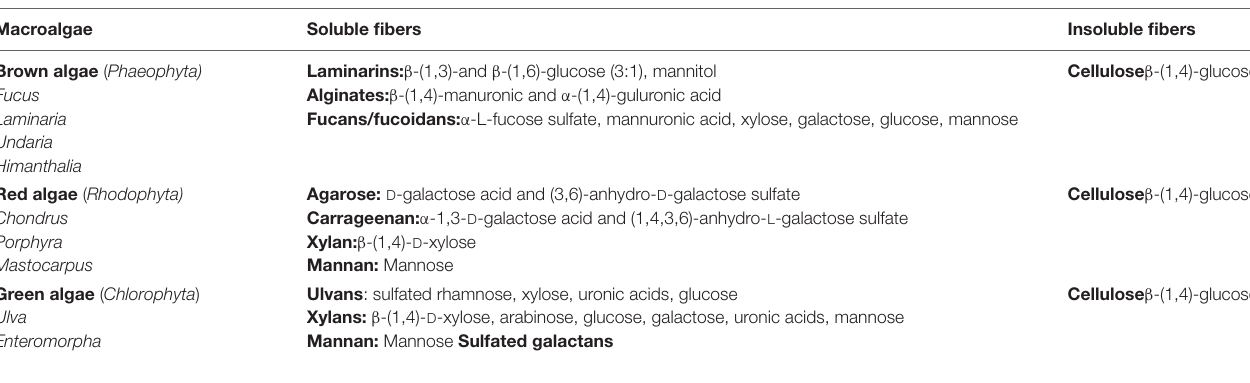
TABLE 1 | The composition of polysaccharides of food macroalgae fibers. Macroalgae Soluble fibers